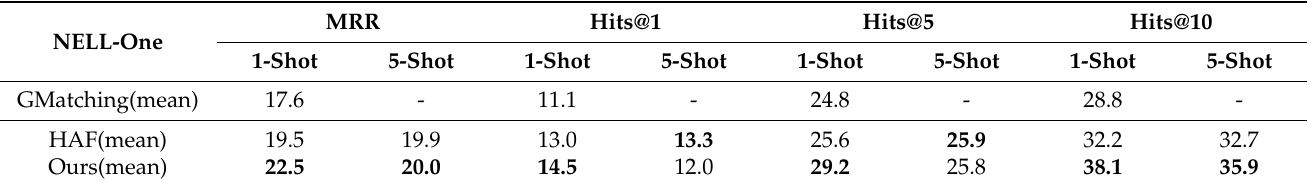
Table 2. The average results of 1-shot and 5-shot experiments of our method and the baseline method on the NELL-One dataset. Bold indicates the best experimental result.